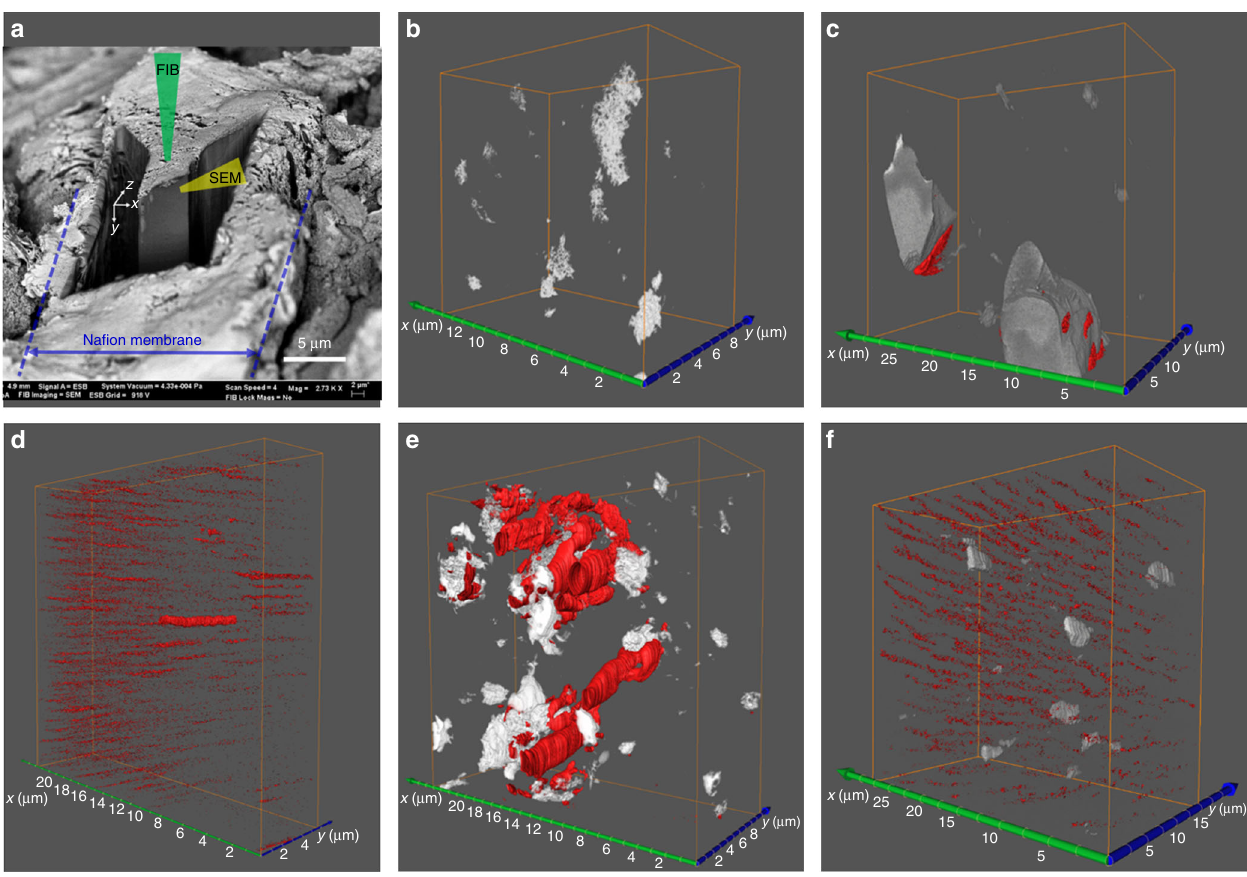
Fig. 4 Investigation of fresh and used Na fi on membranes by FIB-SEM tomography. The white regions correspond to the catalyst (Pt or WC nanoparticles) embedded in the Na fi on membrane, while voids within the Na fi on membrane are depicted in red . a A representative region of PEM sample during FIB-SEM tomographic investigation. The focused ion beam removes a 12 nm-thick layer of the membrane during each pass, while an electron beam records its SEM image. b , c 3D reconstruction of fresh Pt/Na fi on and WC/Na fi on membranes, respectively. d – f 3D reconstruction of used Na fi on, Pt/Na fi on and WC/Na fi on membranes, respectively, after 100 h of fuel cell operation